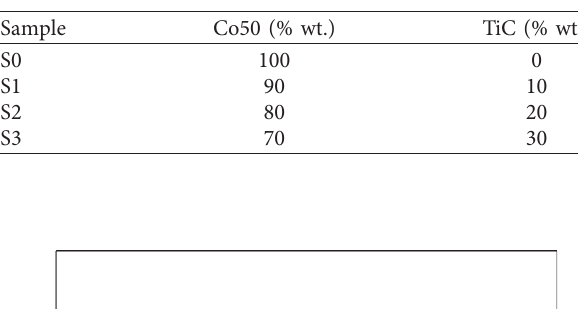
Figure 1: TiC powder used for laser cladding. (a) Topography of TiC. (b) TiC/Co-based preplaced powder layers. Table 3: Technical parameters and sample surfaces of LD method applied in the experiment.